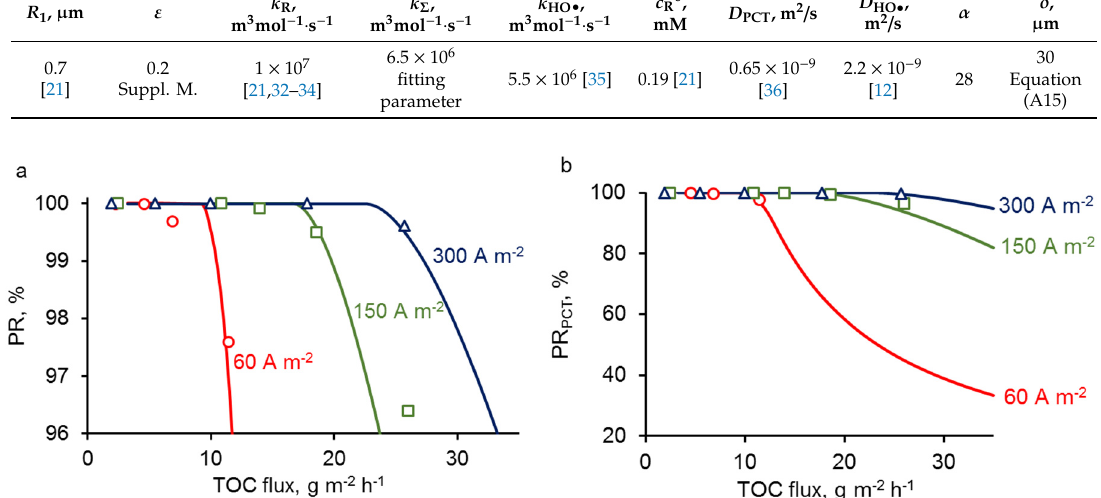
Figure 4. Experimental (dots) and theoretical (lines) dependencies of percentage removal of PCT (PR PCT ) on total organic carbon (TOC) flux at different current densities (mentioned in the figure). All other parameters are presented in Table 1. ( a ) is a zoomed version of ( b ).